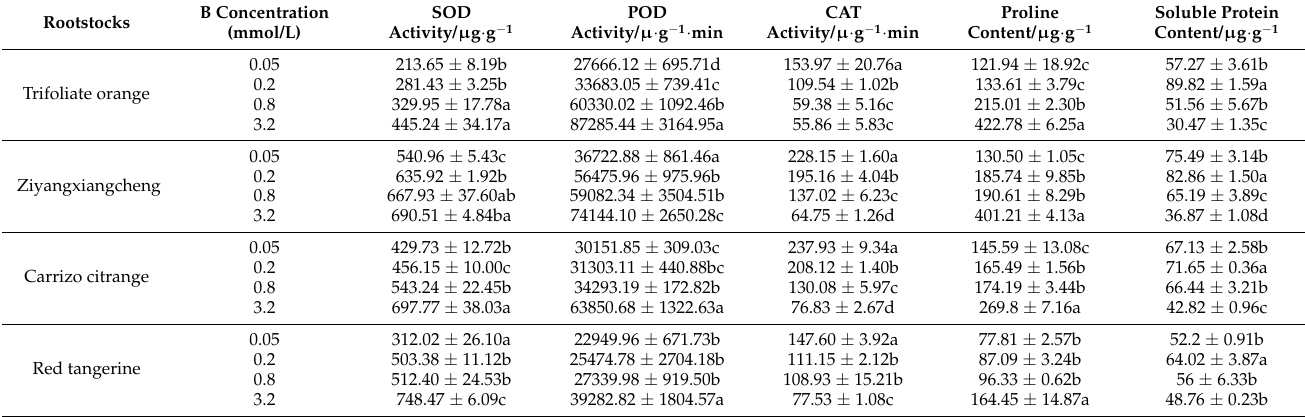
Table 6. The impact of excess B stress on antioxidant enzyme activity and osmotic regulators in the leaves of four citrus rootstock